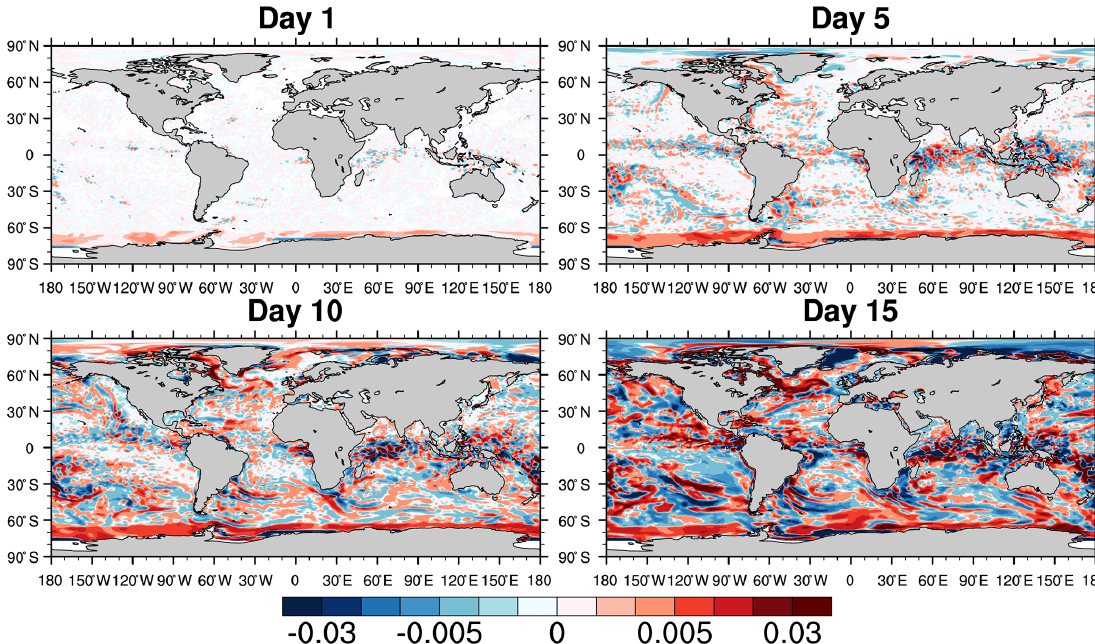
Figure 4. Daily mean differences in sea surface salinity (SSS) between ensemble means of experiments m06e and e011 (each has five members) on day 1 (1 January 1850), 5, 10, and 15 after initialization. Note the nonuniform color